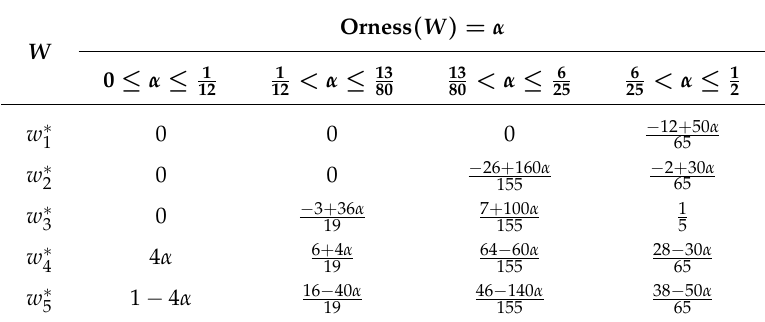
Table 1. The LSD solution OWA operator